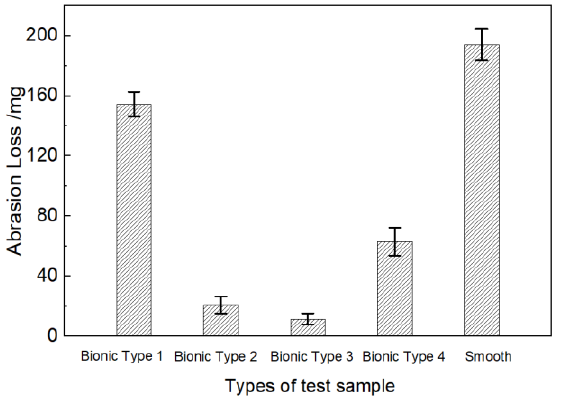
Figure 5. Abrasion loss of 5 types of test sample.